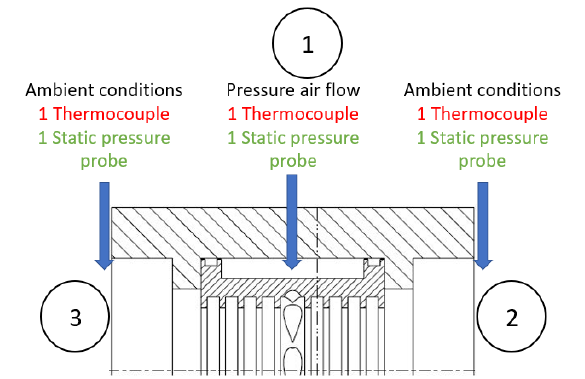
Figure 9. Measurement experimental device instrumentation